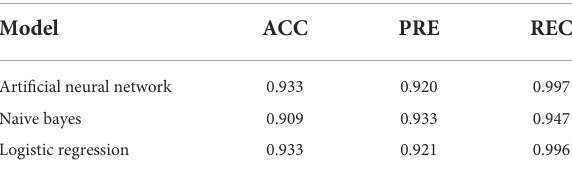
TABLE 7 Comparison of the prediction effect on three